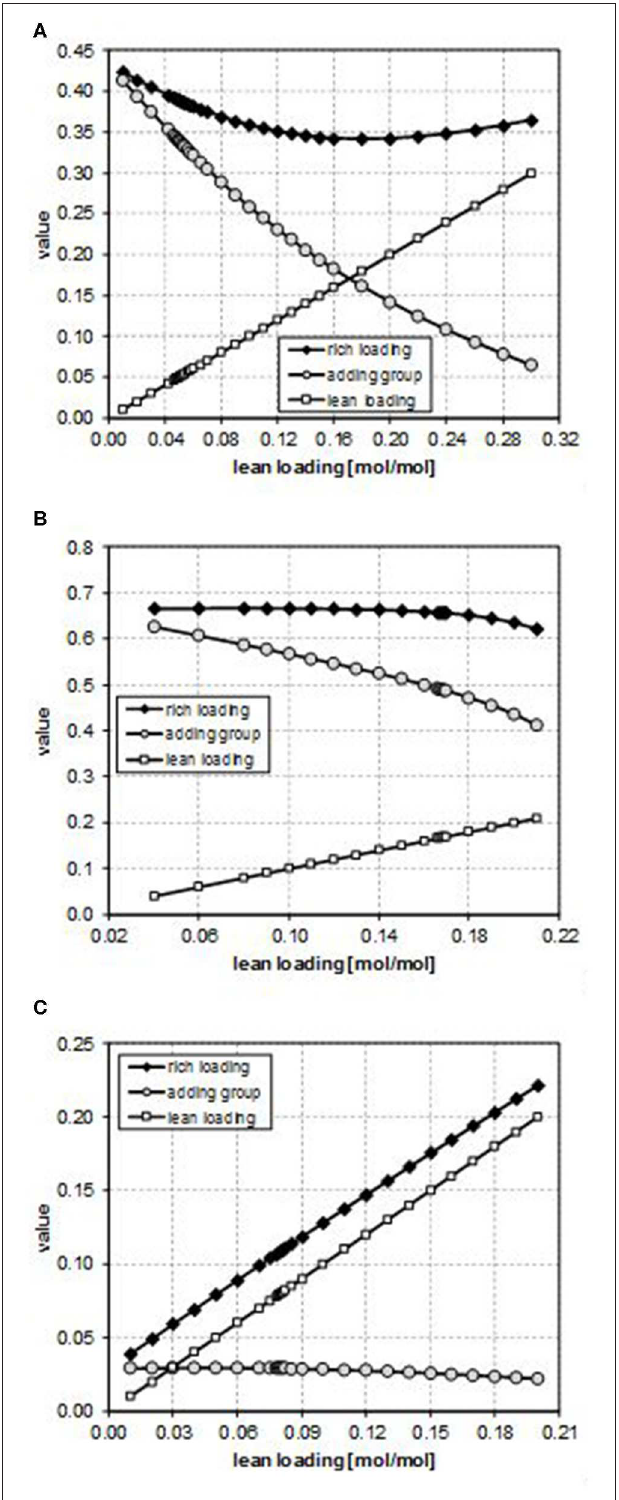
FIGURE 6 | Effect of the CO 2 lean loading on the second term (“adding group”) of Equation (4) for (A) case B , (B) case E , and (C) case G